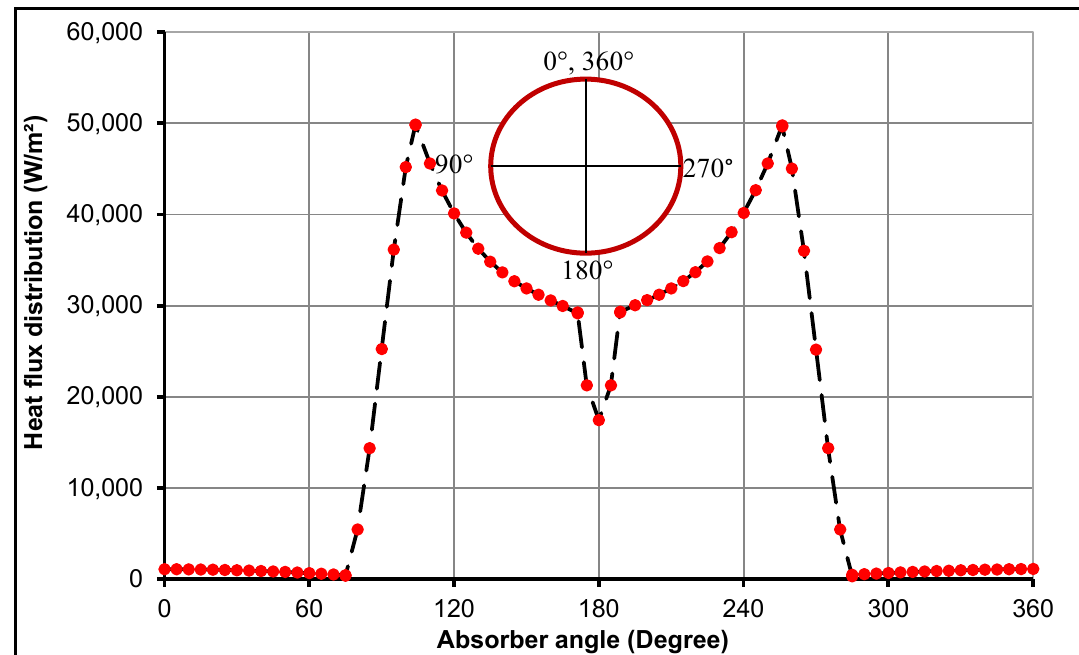
Figure 5. Non-uniform heat flux profile on the outer surface of the absorber receiver.